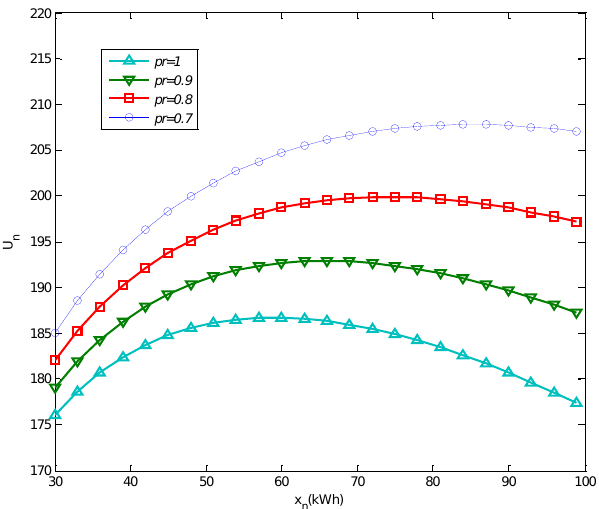
Figure 4. The relationship between prosumer’s integral utility and power consumption ( 𝑘 n = 60).